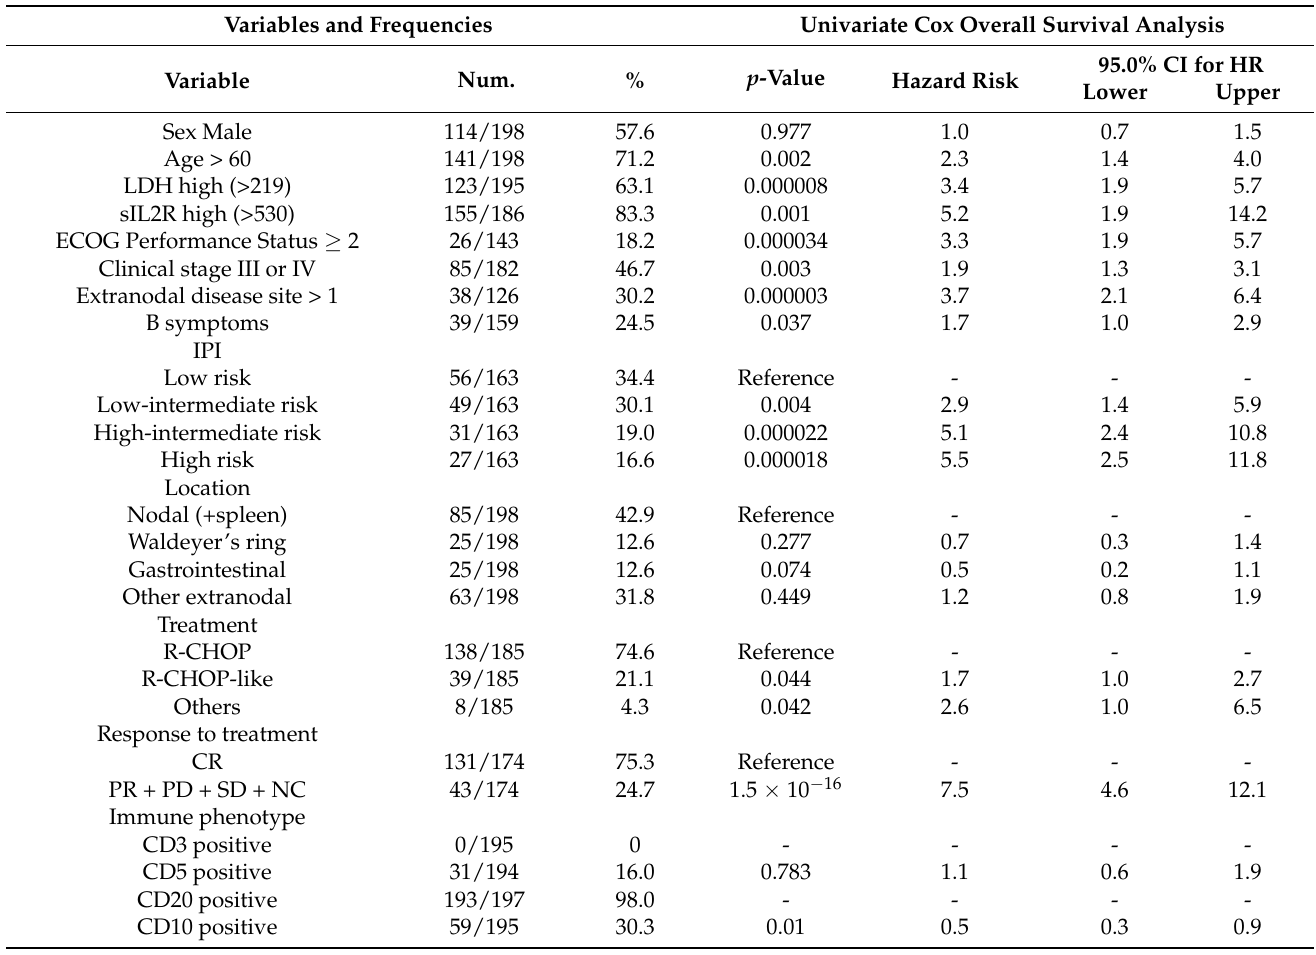
Table 1. Clinicopathological characteristics of the DLBCL series of the Tokai University Hospital (Japan). Variables and